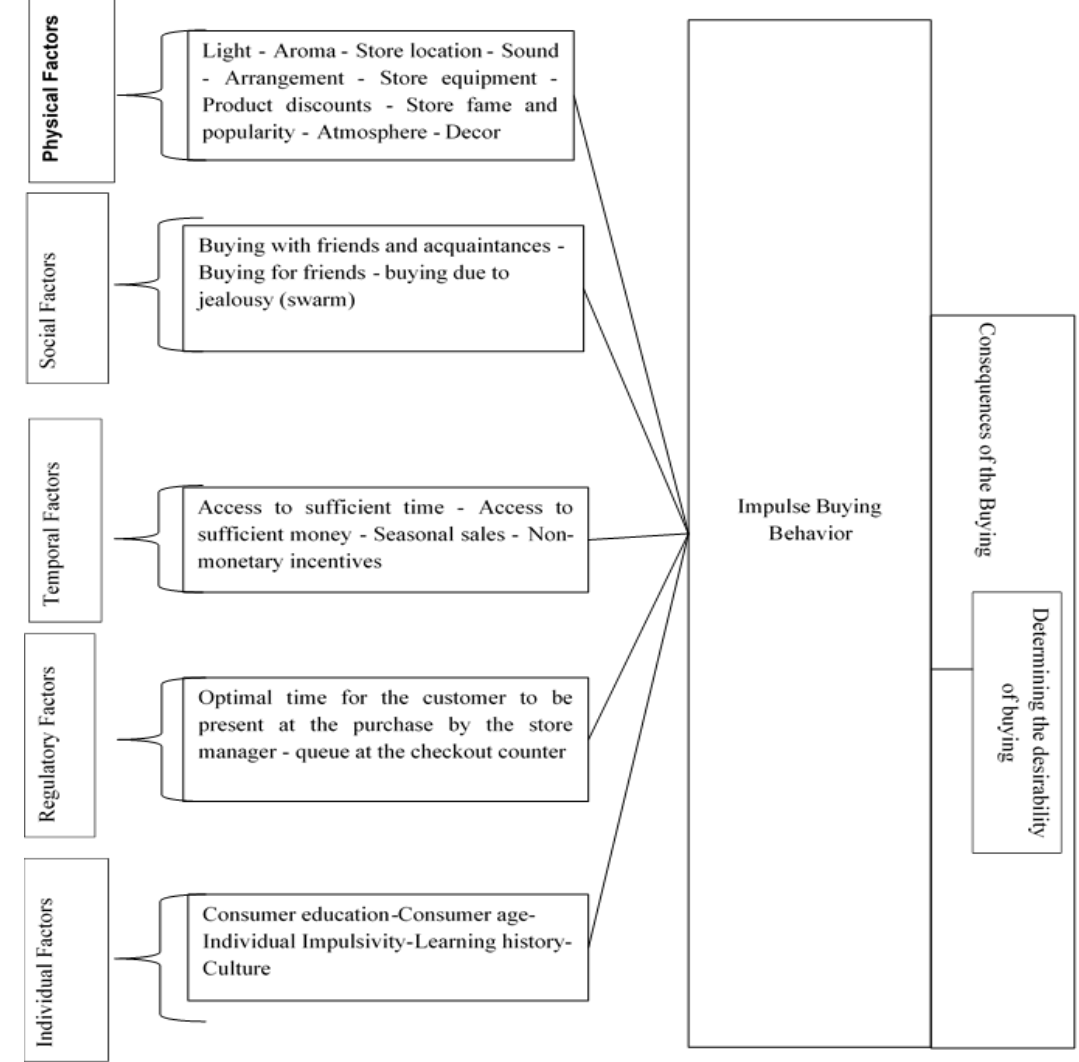
Fig. 1. Behavioral perspective model [16], [18],